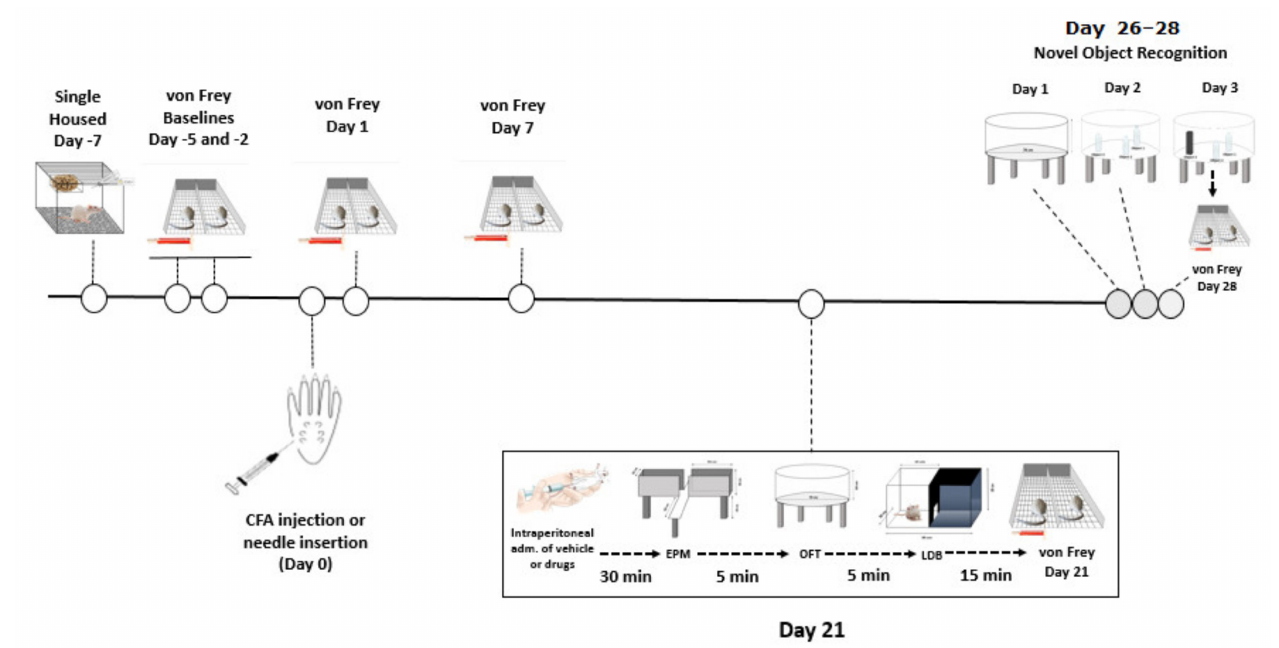
Figure 1. Graphical representation of the experimental